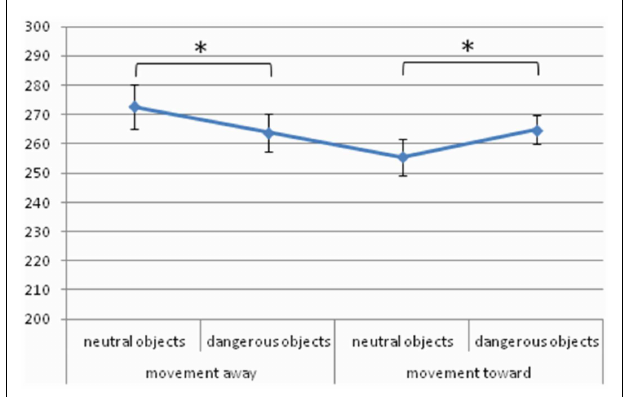
FIGURE 2 | Significant Object Category × Object Movement Direction interaction for RTs in Experiment 1, values are in milliseconds and bars are SEM